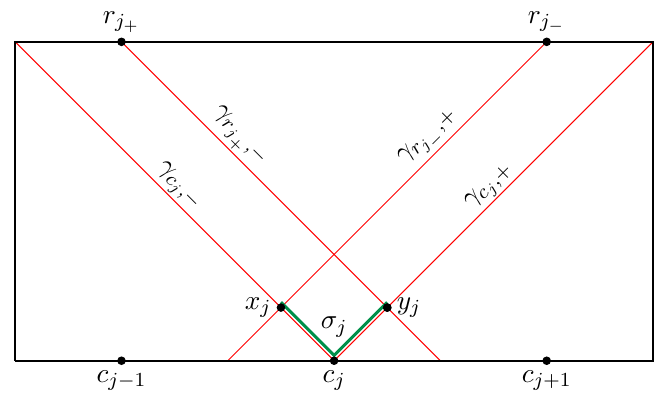
Figure 4. Illustration of a number of definitions appearing in the main text. The curve σ j is shown in